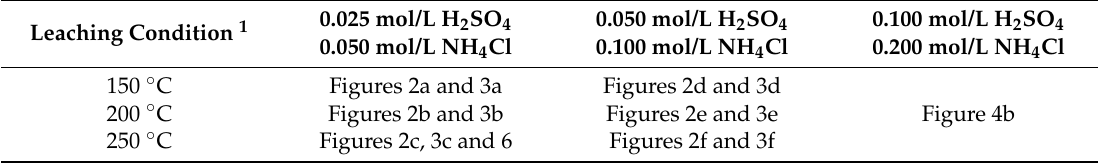
Table 2. Design of the microscopic analysis.